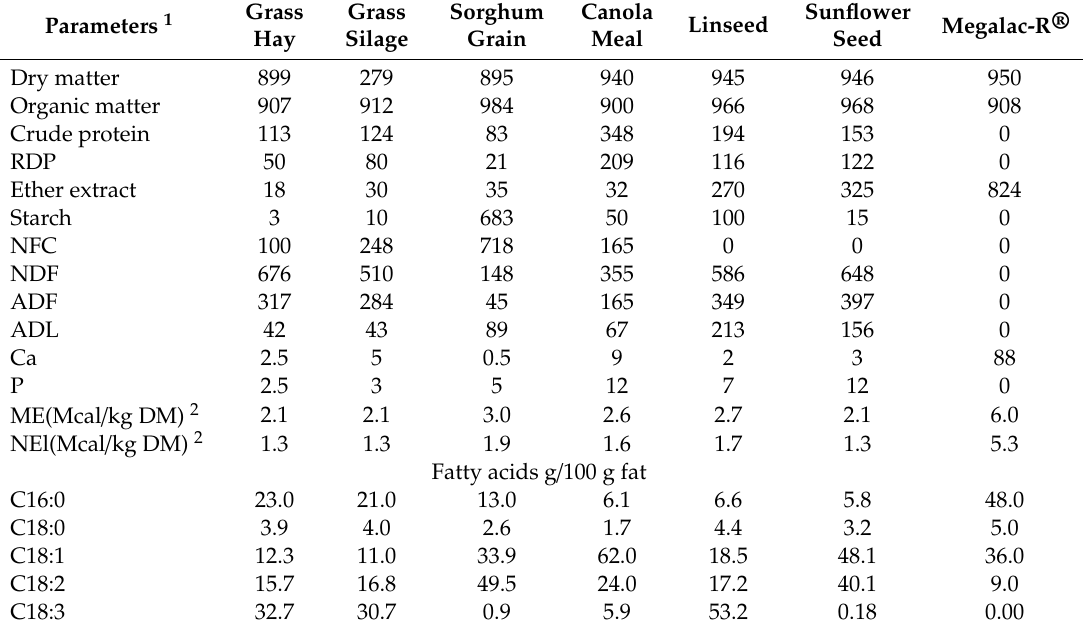
Table 1. Chemical composition (g / kg DM) of individual feedstu ff s and lipid supplements used in the experimental